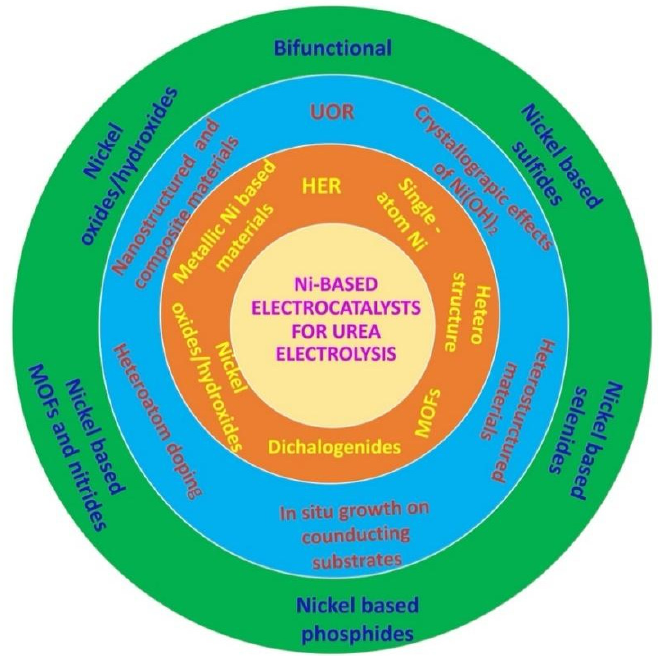
Figure 2. Scheme organization of the Ni-based HER, UOR and the bifunctional electrocatalysts dis- cussed in this review.